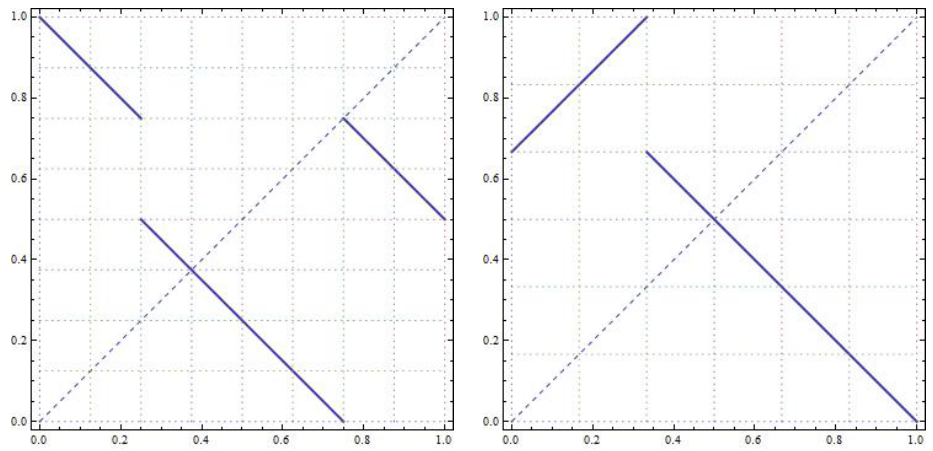
Figure 2. The graph of a ( 3,3 ) -IET with permutation ( − 3, − 1, − 2 ) and a = 0.25 ( left ). On the ( right ), the graph of its Poincaré